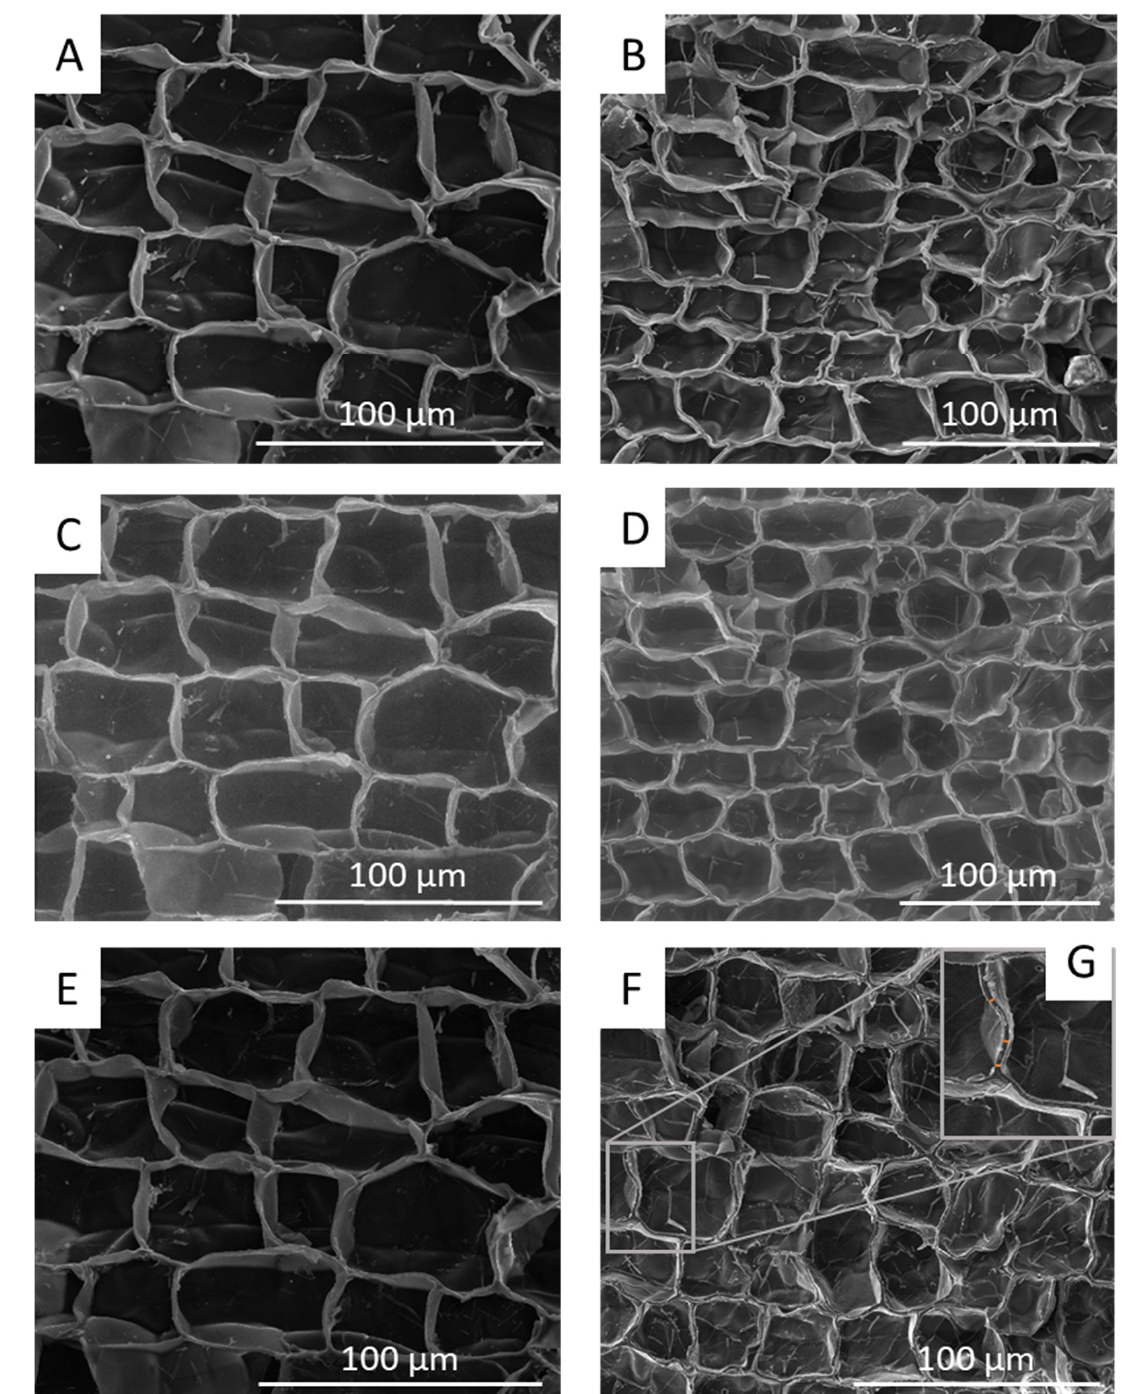
Figure 1. Microphotographs of the cork cell structure of a transverse section of a cork sample from the fertigated plot ( A , C , E ) and a cork sample from the rainfed plot ( B , D , F ): ( A , B ) were obtained using SEM on raw cork; ( C , D ) were obtained using ESEM after 24 h immersion in cold water; ( E , F ) were obtained with SEM after boiling and two days of drying. ( G ) Yellow marks represent an example of a cell wall thickness measurement.